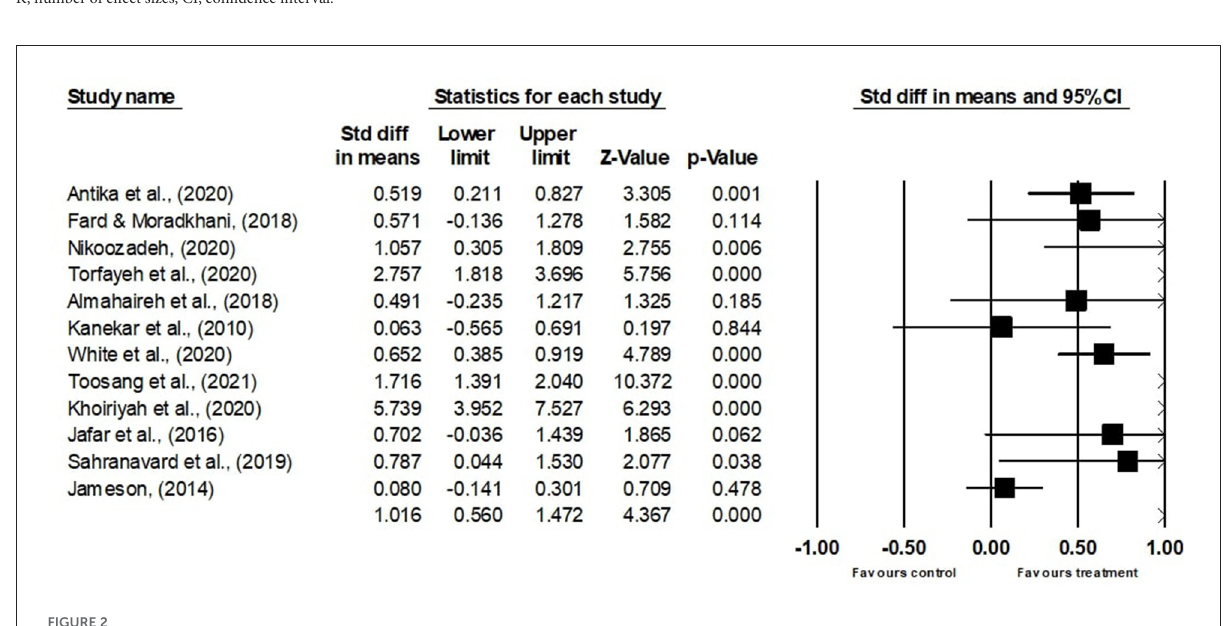
FIGURE2 Forest plot for the random-effects